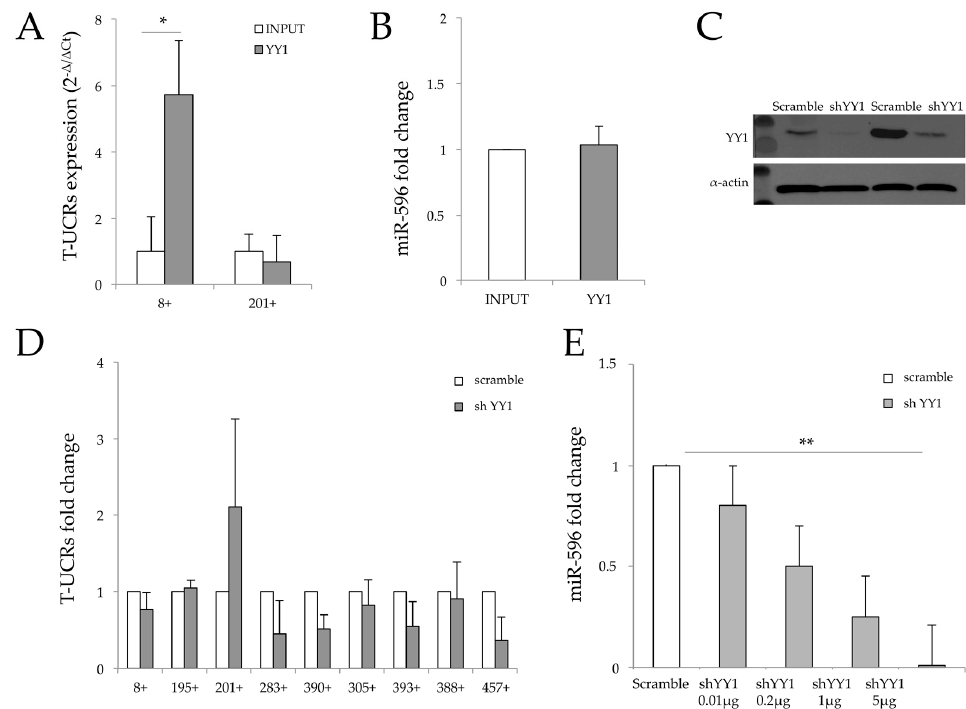
Figure 3. Role of polycomb YY1 in T ‐ UCR network. ( A ) RNA ‐ chromatin immunoprecipitation (RNA ‐ ChIP) using YY1 and antibodies followed by real ‐ time PCR (RT ‐ PCR) with T ‐ UCR 8+ and T ‐ UCR 201+ set ‐ primers on pull down materials. Data were expressed as Δ Ct of the housekeeping gene U6 and fold change to non ‐ immunoprecipitated samples INPUT (non ‐ immunoprecipitated material) and reported as 2 −Δ / Δ C t ; ( B ) RNA ‐ ChIP immunoprecipitation using YY1 antibodies followed by RT ‐ PCR with miR ‐ 596 set ‐ primers on pull down materials. Data were expressed as Δ Ct of the housekeeping gene U6 and fold change to non ‐ immunoprecipitated samples INPUT (non ‐ immunoprecipitated material); ( C ) Total protein extracts from J82 cell lines transfected with pbloKit ‐ shYY1 and pbloKit ‐ scramble vectors analysed by Western blot using YY1 antibody. Actin was used as control to equally load the samples; ( D ) real time PCR (RT ‐ PCR) of the selected T ‐ UCRs, in shYY1 ‐ silenced J82 cells compared to empty vector ‐ transfected cells. White boxes indicate cells transfected with pblockiT scramble vector, and grey boxes indicate cells transfected with pblockiT shYY1; ( E ) qRT ‐ PCR of miR ‐ 596 in pblockiT ‐ scramble ‐ transfected cells (white box) and cells transfected with pblockiT shYY1 at different doses as indicated (grey boxes). Data are reported as fold change considering pblockiT ‐ scramble equal to 1 and as mean ± SD of triplicate values. p values were obtained using the Student t ‐ test for three independent samples. * p < 0.05, ** p < 0.01 vs . control.